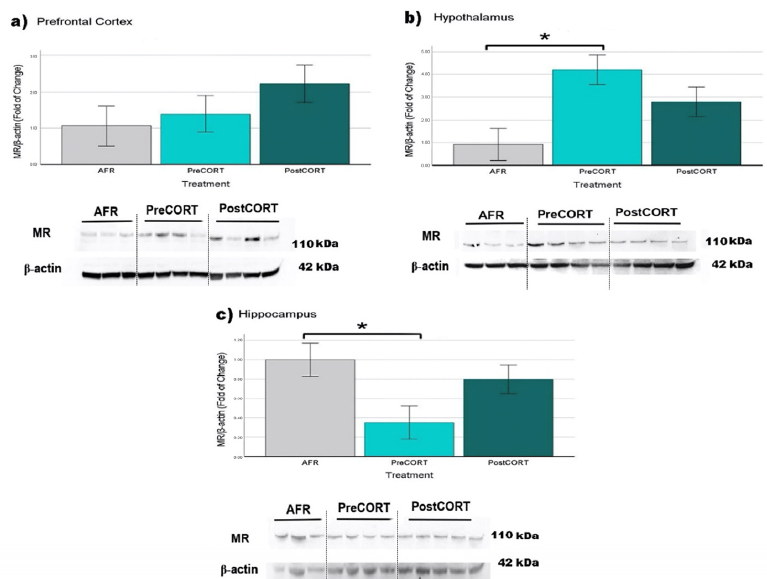
Figure 14. Mineralocorticoid receptors (MR) expression. Histograms and representative bands of MR expression in ( a ) prefrontal cortex, ( b ) hypothalamus and ( c ) hippocampus in AFR ( n = 5, pre- frontal cortex; n = 6, hypothalamus; n = 6, hippocampus); PreCORT ( n = 6, prefrontal cortex; n = 7, hypothalamus; n = 6, hippocampus) and PostCORT ( n = 6, prefrontal cortex; n = 7, hypothalamus; n = 8, hippocampus) subjects (* p < 0.05). Each lane corresponds to different mice. Data are presented as mean ± SEM (* p < 0.05).